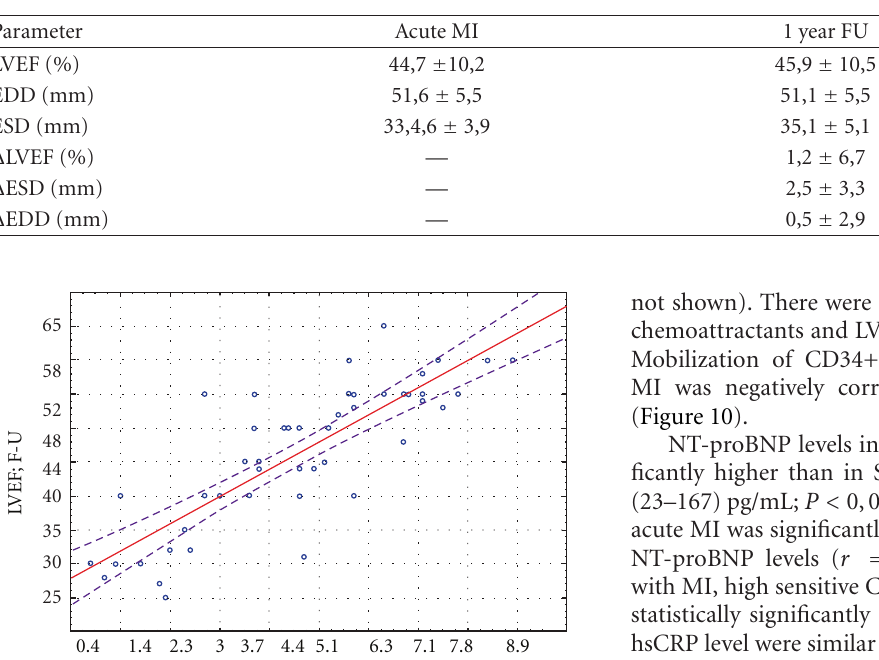
Table 3: Left ventricle ejection fraction and remodeling in 1-year follow-up in patients with MI.